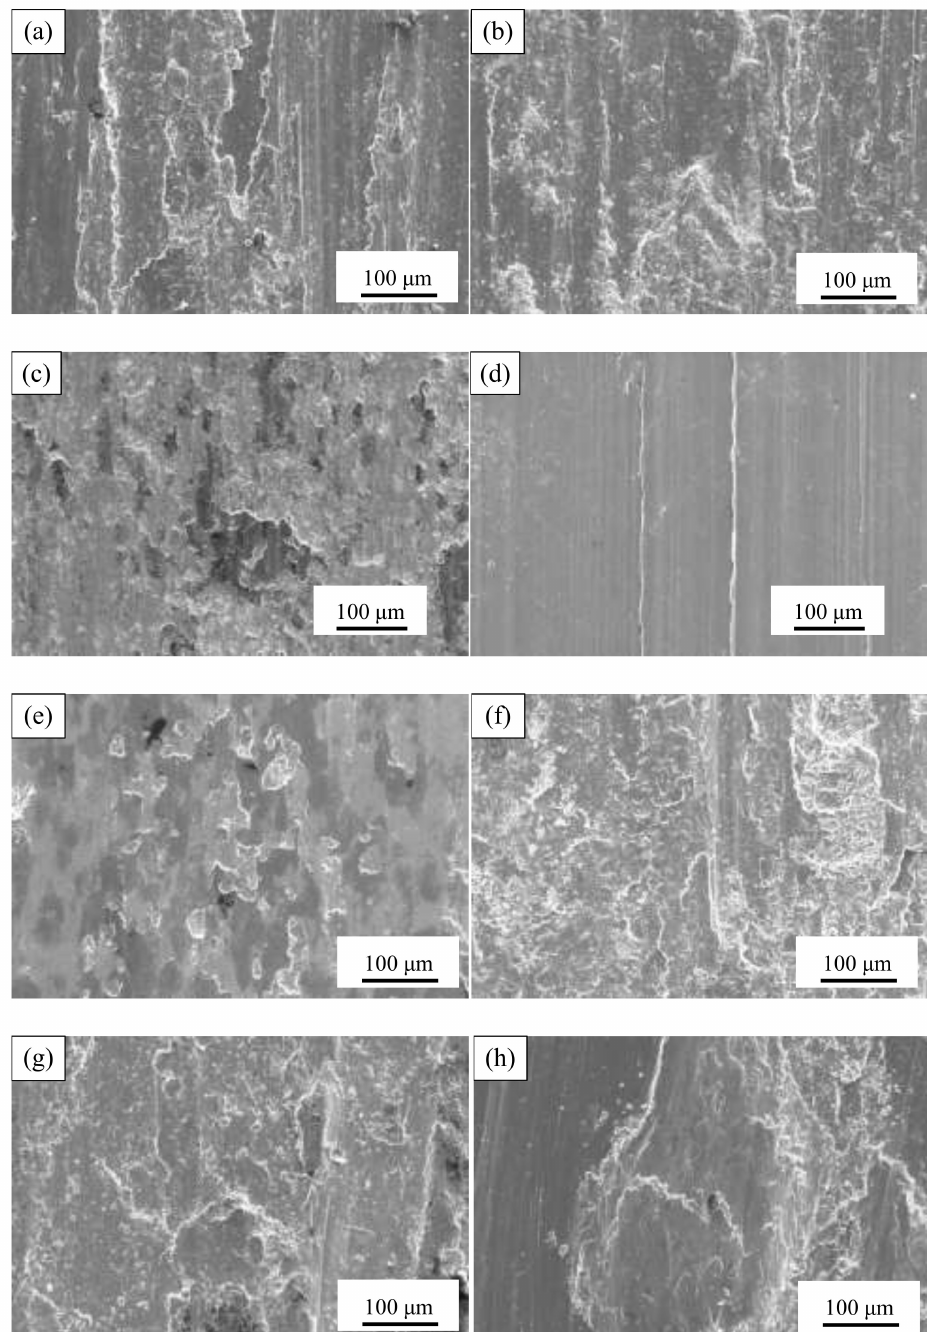
Figure 11. Surface wear trace micrographs: ( a , b ) Ti6Al4V substrate and Ti6Al4V friction pair; ( c , d ) WC-10Ni and Ti6Al4V friction pair; ( e , f ) Ni45 and Ti6Al4V friction pair; ( g , h ) NiCr and Ti6Al4V friction